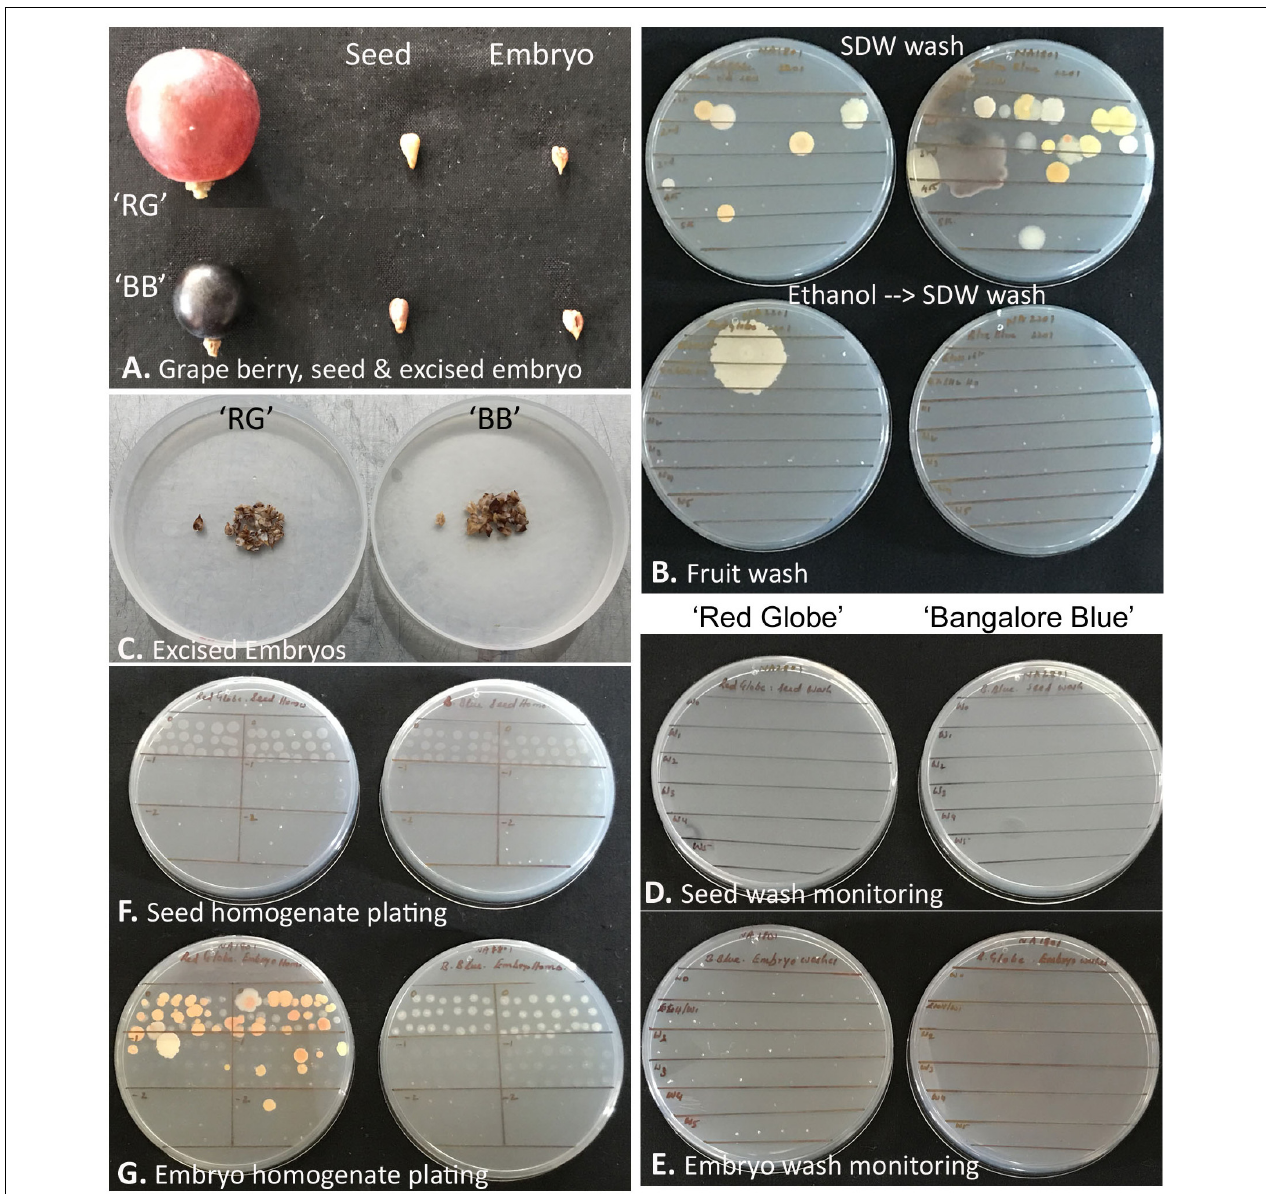
FIGURE 7 | Description of grapevine seed versus excised seed-embryo 16S rRNA V3–V4 amplicon-based taxonomic profiling. (A) Berry, seed, and excised seed-embryo in ‘Red Globe’ (‘RG’) and ‘Bangalore Blue’ (‘BB’). (B) Monitoring the fruit wash solutions for the microbial load by spotting on nutrient agar, the upper panel showing results after six sterile distilled water (SDW) washes, and the lower panel showing the outcome after one ethanol wash followed by six FDW washes. (C) Excised embryos from the seeds of ‘RG’ and ‘BB.’ (D) Monitoring seed-wash solutions. (E) Monitoring embryo-wash solutions. (F) Testing the seed-tissue homogenate for cultivable bacteria through SP-SDS of serial dilutions with no bacterial CFU for 2–4 weeks. (G) Seed-embryo homogenate tested for cultivable bacteria through SP-SDS showing bacterial CFU after 2–4